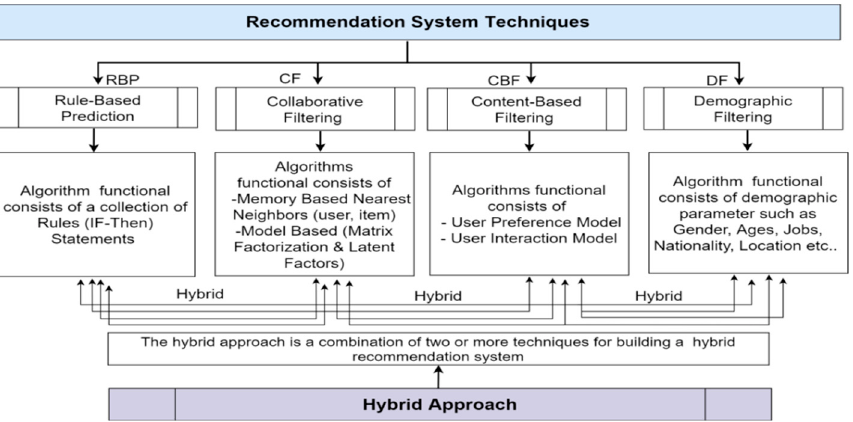
Figure 3. Hybrid approach based recommendation system techniques.